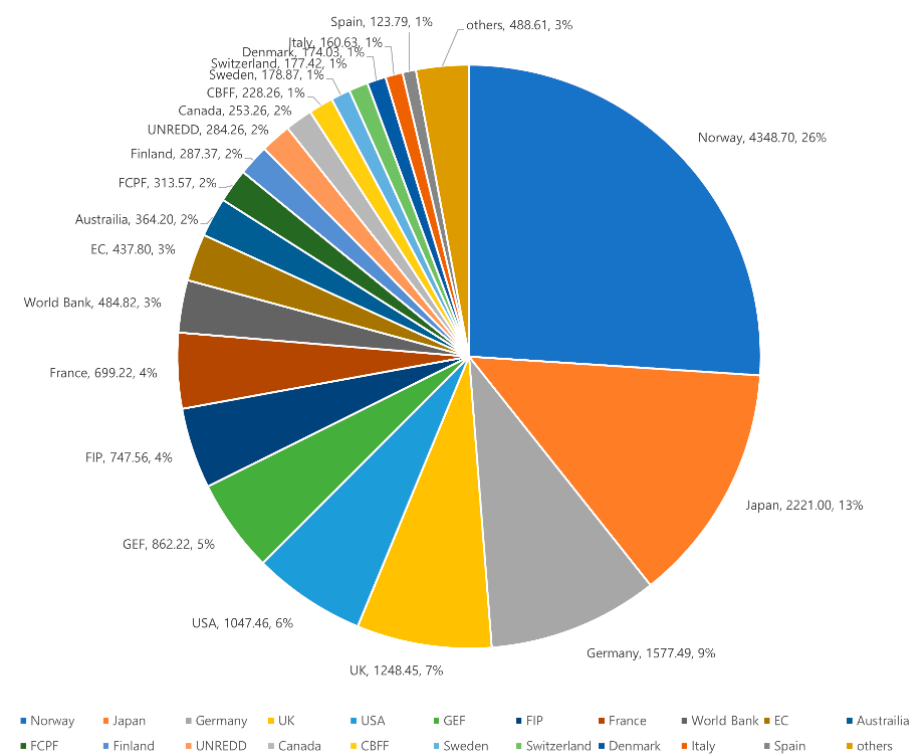
Figure 11. Amount of REDD+ finance (as a percentage of a total of 16.7 billion U.S. dollars) given by donors between 2006 and 2015.